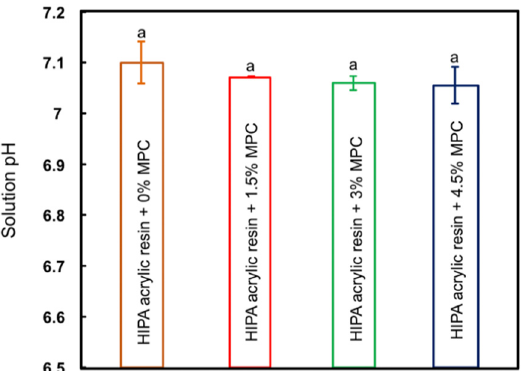
Figure 4. Solution pH values of HIPA groups with MPC at 0%, 1.5%, 3%, and 4.5% (mean ± SD; n = 4). All groups demonstrated solution pH values that were not significantly different from each other (pH ≅ 7) ( p > 0.05).